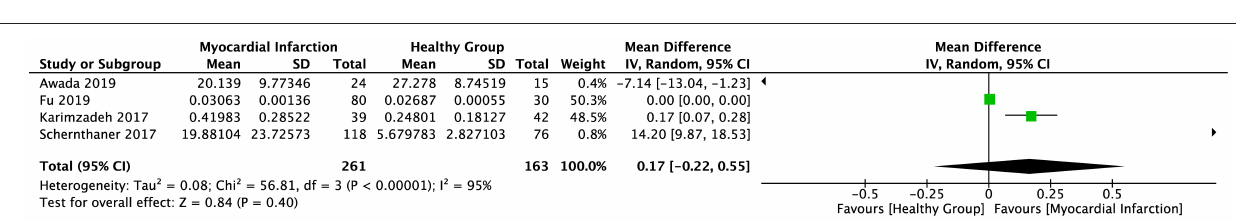
FIGURE 3 | Forest plot of sST2 levels between IHD and healthy groups.